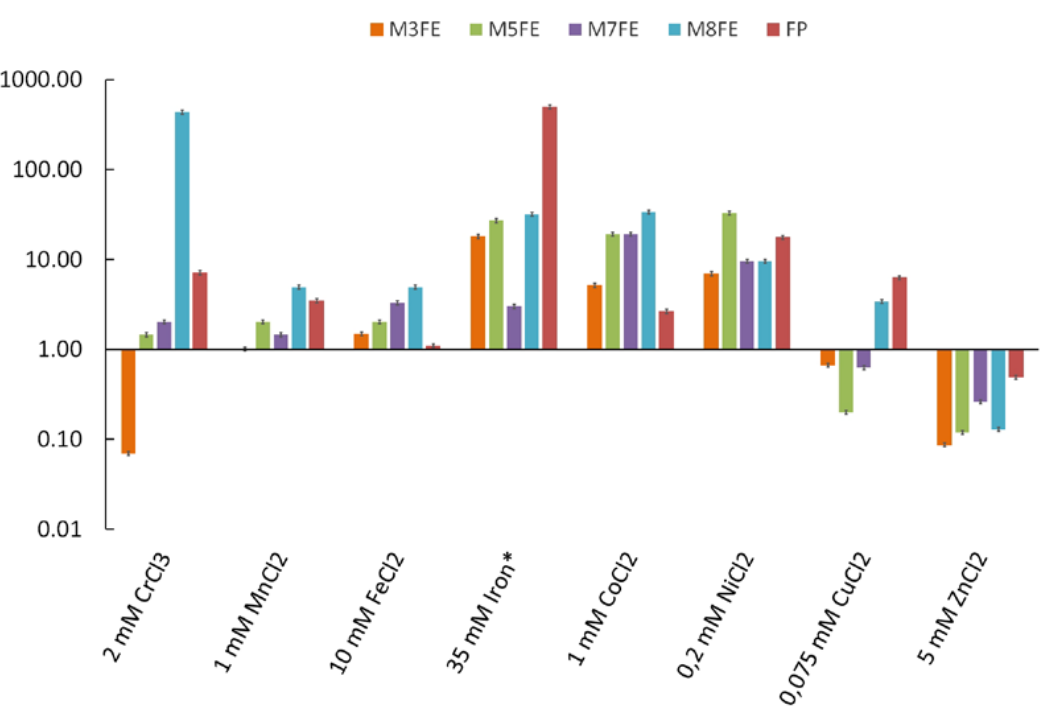
Figure 1. Survival rates as folds of the reference strain ( 905 ) of the mutants ( M3FE , M5FE , M7FE , M8FE ) and the final population (FP), represented in log-scale. The results were obtained using the MPN analysis under various metal stress conditions. Iron* indicates (NH 4 ) 2 Fe(SO 4 ) 2 .